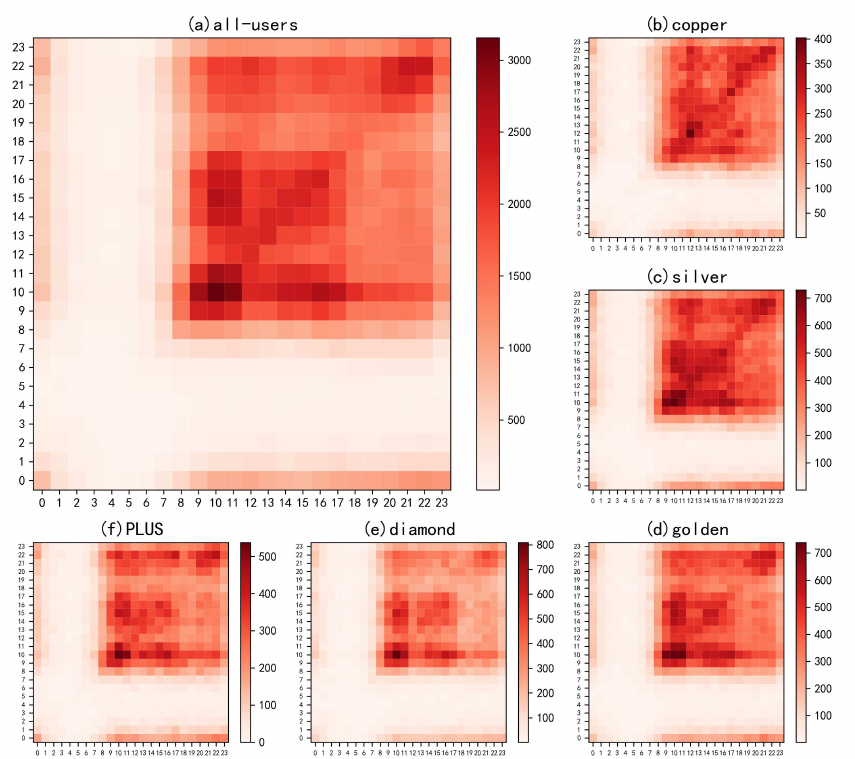
Figure 4. Heatmaps of hours for RC and PP of negative reviews, taking the sector Computers as an example. The x -axis refers to the hour of PP, and the y -axis refers to that of RC. Every patch corresponds with an RC and PP pair, and the color in it refers to its frequency, i.e., the darker red means a greater frequency. The results of the four sectors are